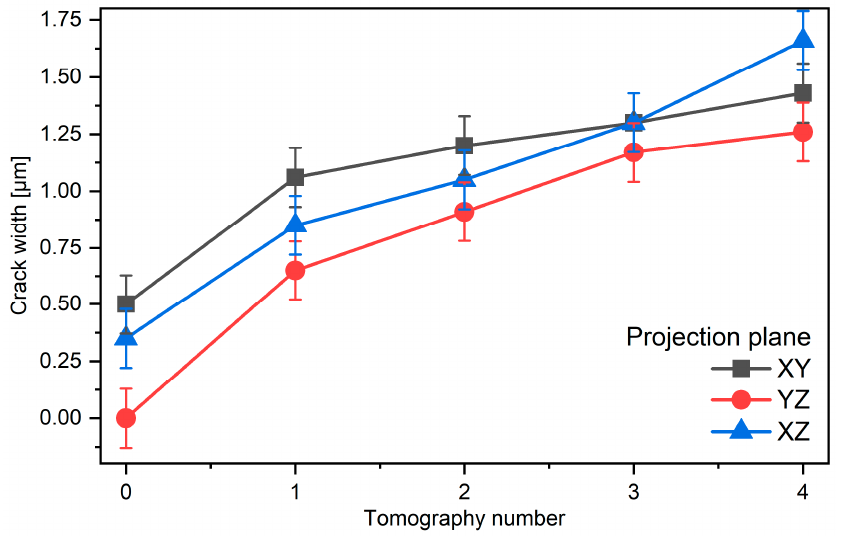
Figure 4. Evolution of microcracks in the particle marked in Figure 3. Growth of the most pronounced cracks in three different virtual cross-sections is shown as a function of tomography number. The error bar corresponds to the voxel size of 129 nm 3 .